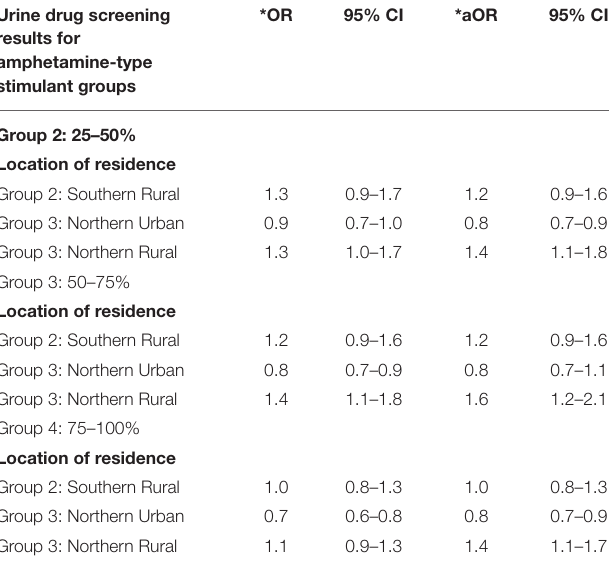
TABLE 4 | Subgroup analysis: unadjusted and adjusted multivariable logistic regression model of geographical location associated with amphetamine-type stimulant use groups among individuals in OAT in Ontario,